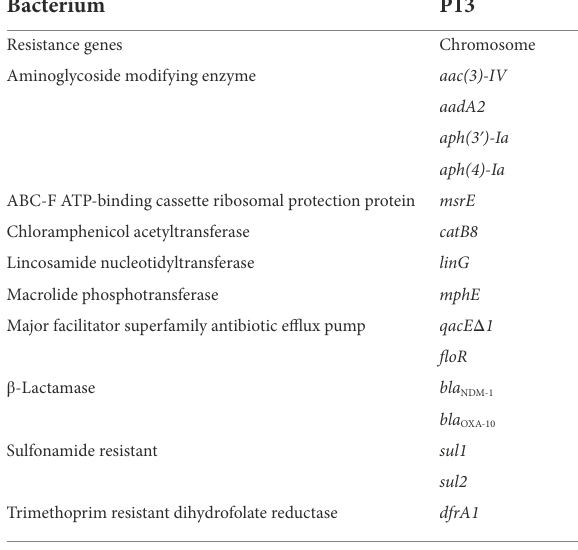
TABLE 5 Resistance genes identified in P. vermicola P13.